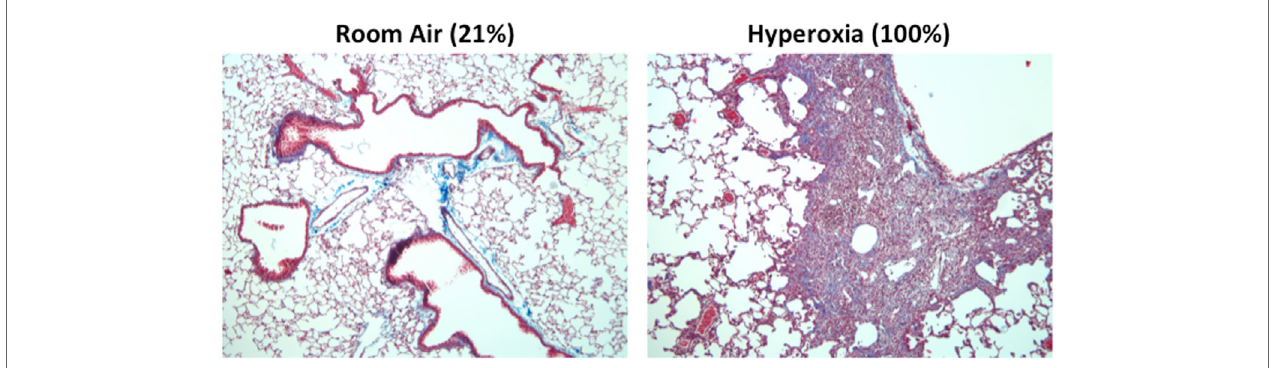
Trichrome staining revealed extensive collagen deposition and inflammation in infected mice exposed to neonatal hyperoxia 14 days post infection. This pathology was not evidence in infected siblings exposed to room air at